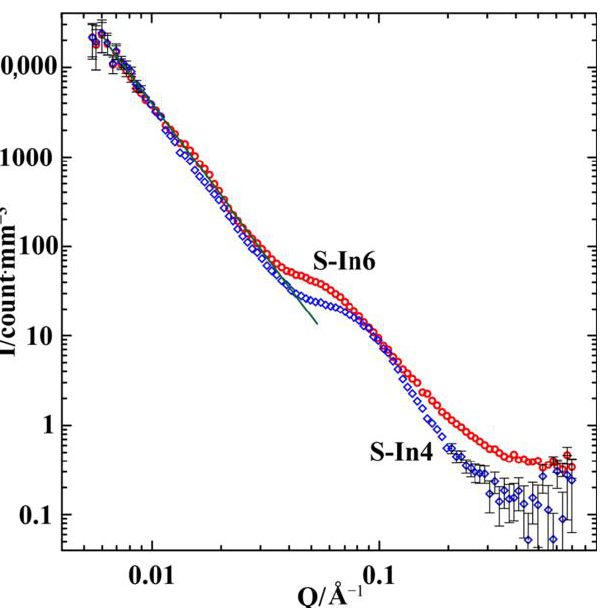
Figure 2. Normalized SANS intensities in the samples with alloy compositions 96 at.% Ga/4 at.% In (S-In4, blue diamonds) and 94 at.% Ga/6 at.% In (S-In6, red circles). The straight green line corresponds to the I ( Q )~ Q −3 . 2 dependence.